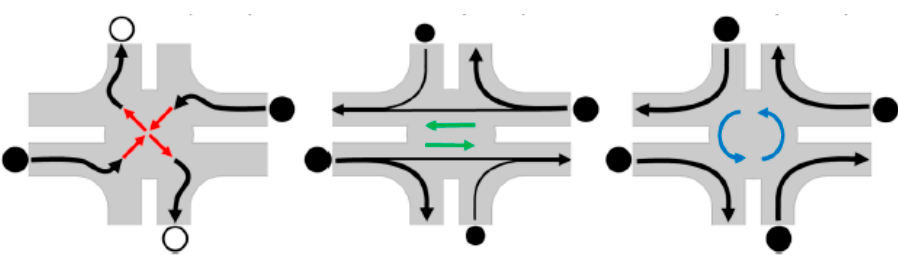
Figure 7. A schematic of the fluidic Four Roll Mill device in which different flows can be generated. The flows can be created by applying a pressure flow in the channels marked with closed dots and opening the valves in the channels marked with the open dots. The neutron beam is directed along the white path between the flow channels with a diameter of 1 mm. The flow channels have dimensions of 2 × 3 mm 2 (reproduced with permission from [ 66 ], Springer, Nature, 2018).